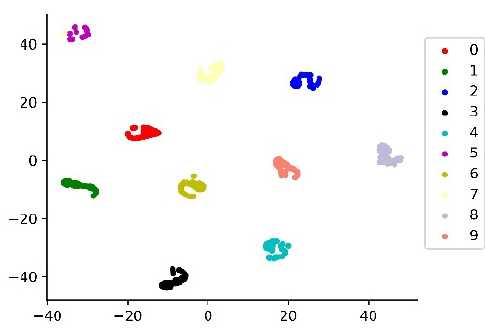
Figure 15. T-SNE visualization. Table 7. Model performance